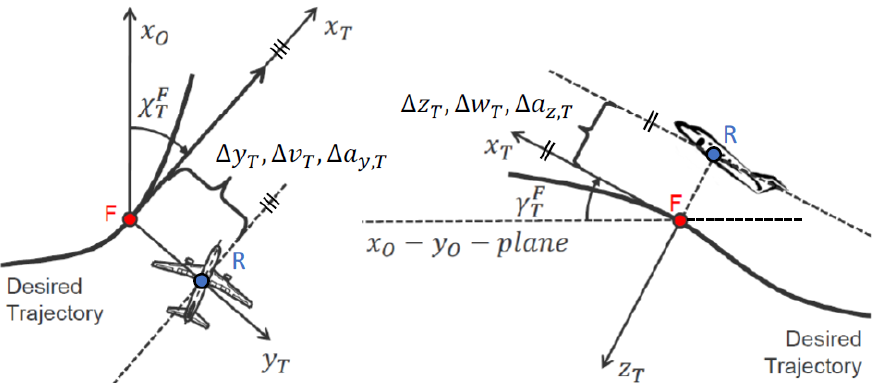
Figure 1. Visualization of basic idea for nonlinear trajectory/path-following controller based on trajectory reference point F , i.e., the foot point along the desired trajectory, as well as the definition of the path deviations and their derivatives (adapted and extended from the work in